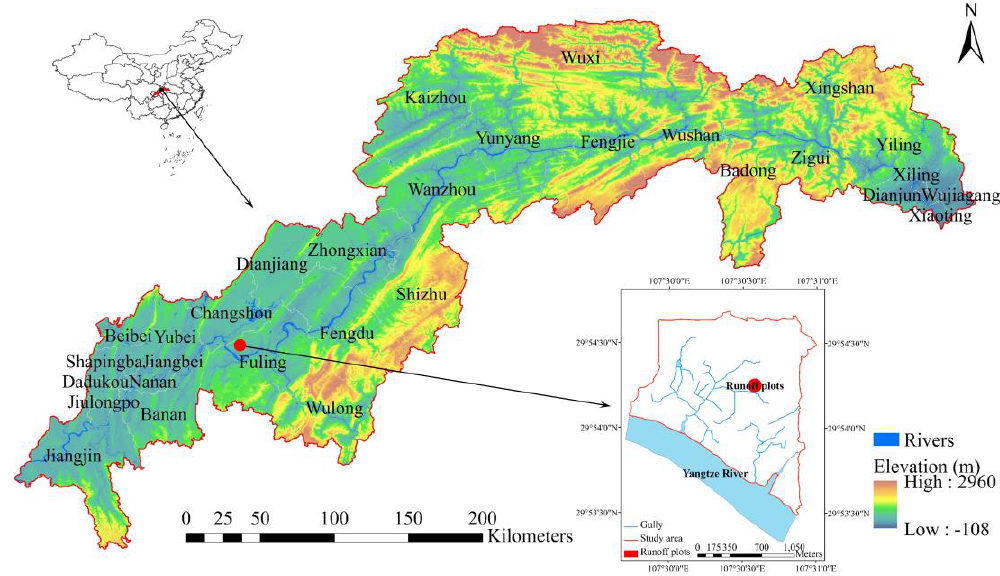
Figure 1. Location of the study area and experimental site.